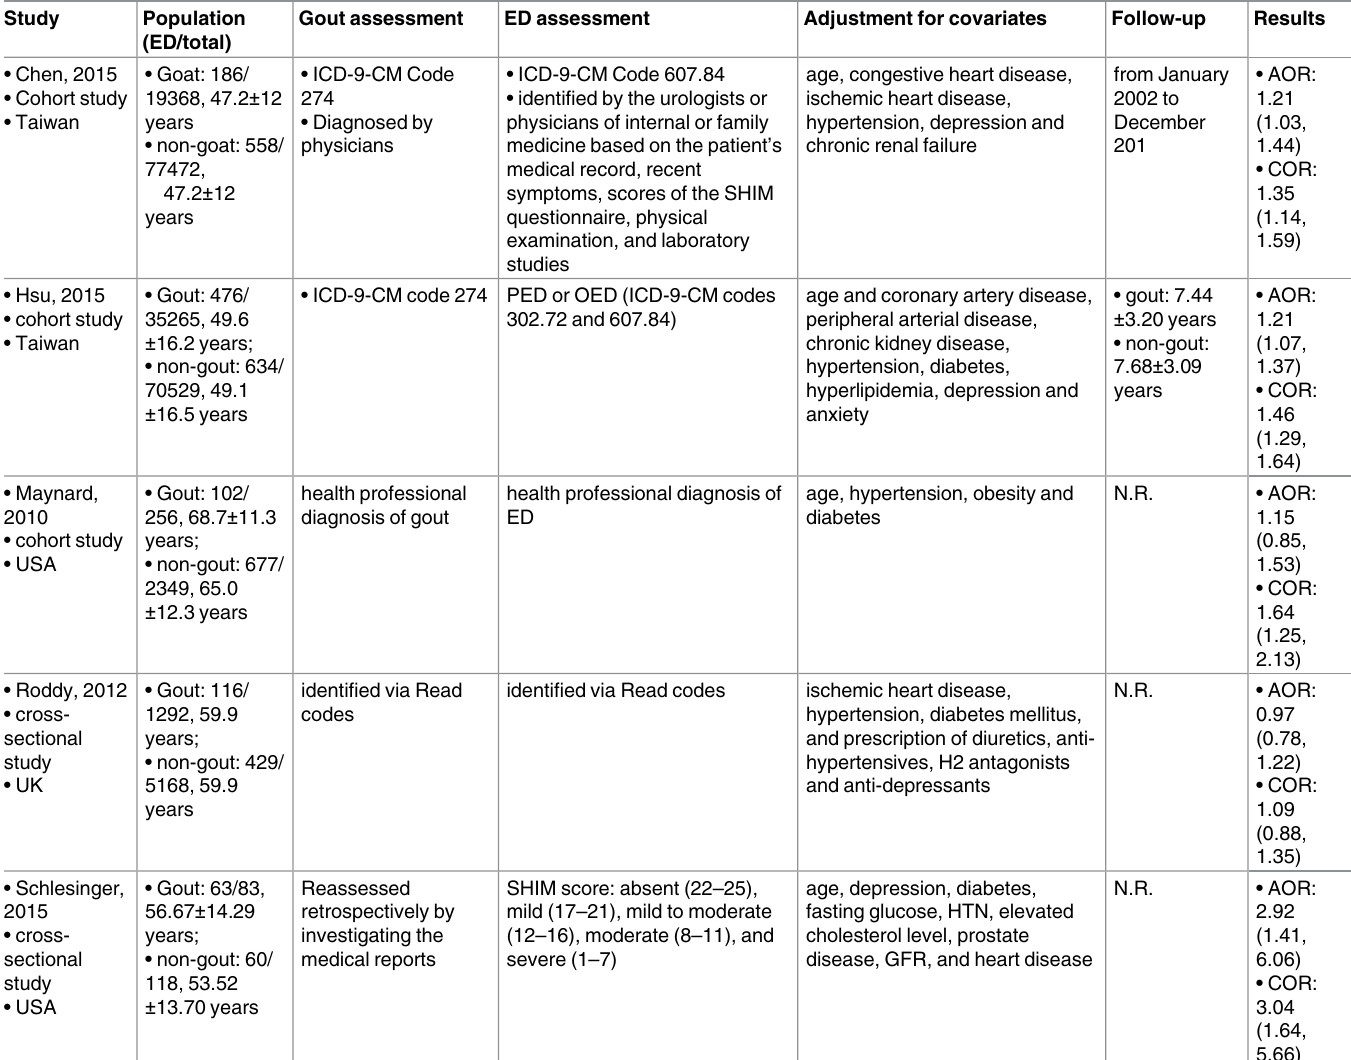
Table 1. Characteristics of included